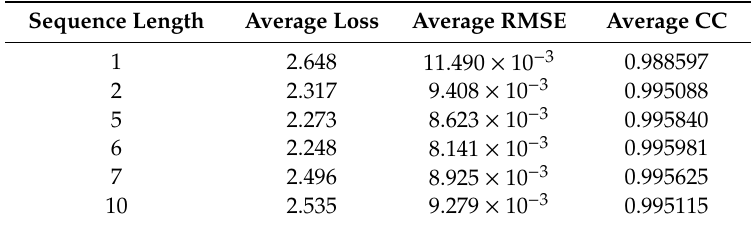
Table 4. E ff ect of sequence length on accuracy.